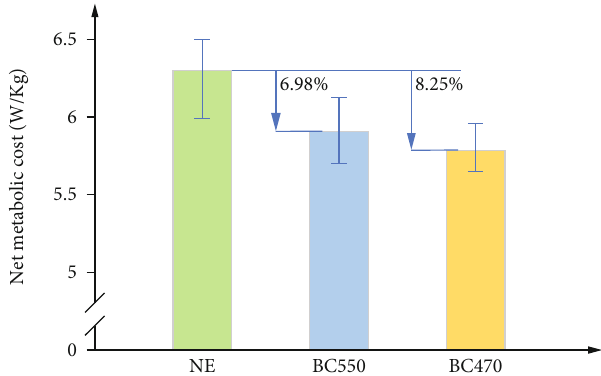
Figure 18: The net metabolic cost comparison of three test